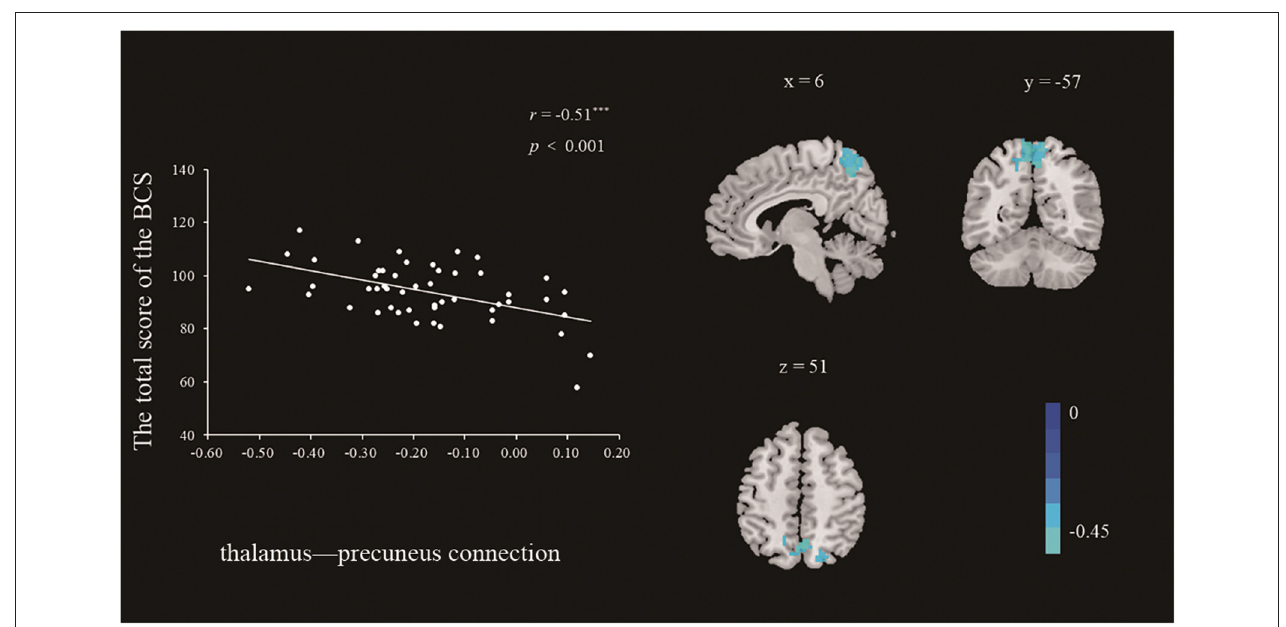
FIGURE 3 | Clusters whose functional connectivity strengths with the left thalamus (seed) were significantly associated with the BCS (right panel). Color bars represent R -values. The functional connectivity strength between the left thalamus and bilateral precuneus was negatively correlated with the BCS (left panel). The scatter plots depicted correlations between functional connectivity strength and individual differences in the BCS scores. The threshold was set at p < 0.01, corrected.